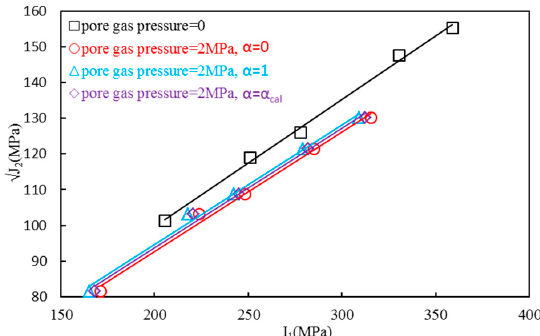
Figure 10. Measured strength data and curves fitted using the Hoek-Brown criterion.